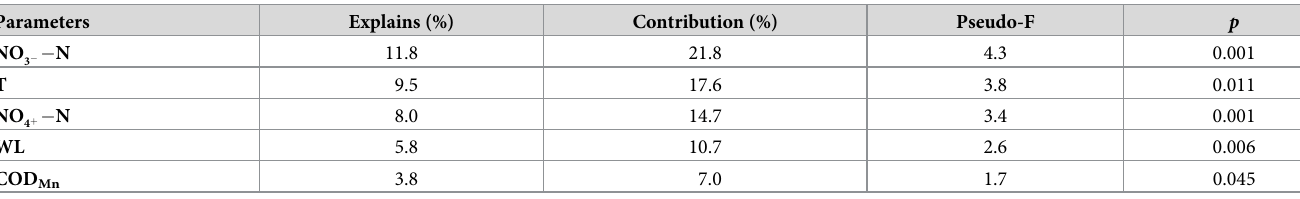
Table 3. The forward selection results of environmental factors in